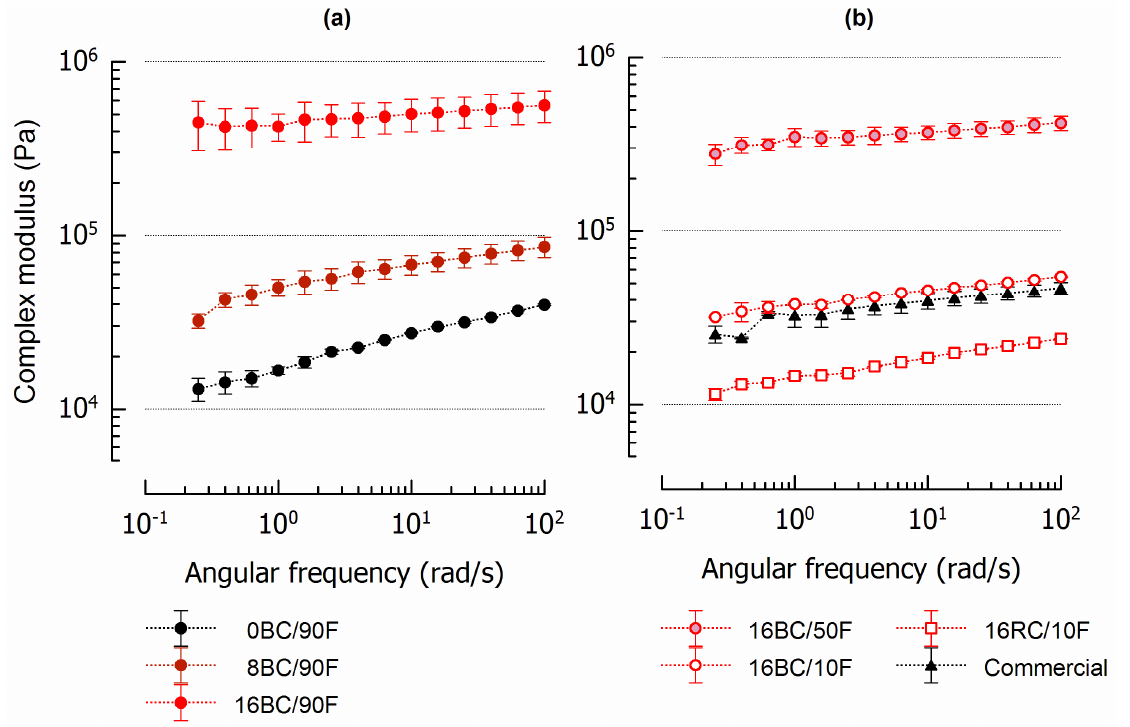
Figure 2. Frequency dependency of sweet spreads at 25 °C: ( a ) Formulations with increasing pomace content; ( b ) Formulations with constant pomace content but varying fat composition plus a com- mercial nut spread. Coding refers to pomace content (g/100 g), pomace variety (BC—blackcurrant; RC—redcurrant), and the fraction of palm fat (F) in total fat (%). To improve clarity, not all data points are plotted.